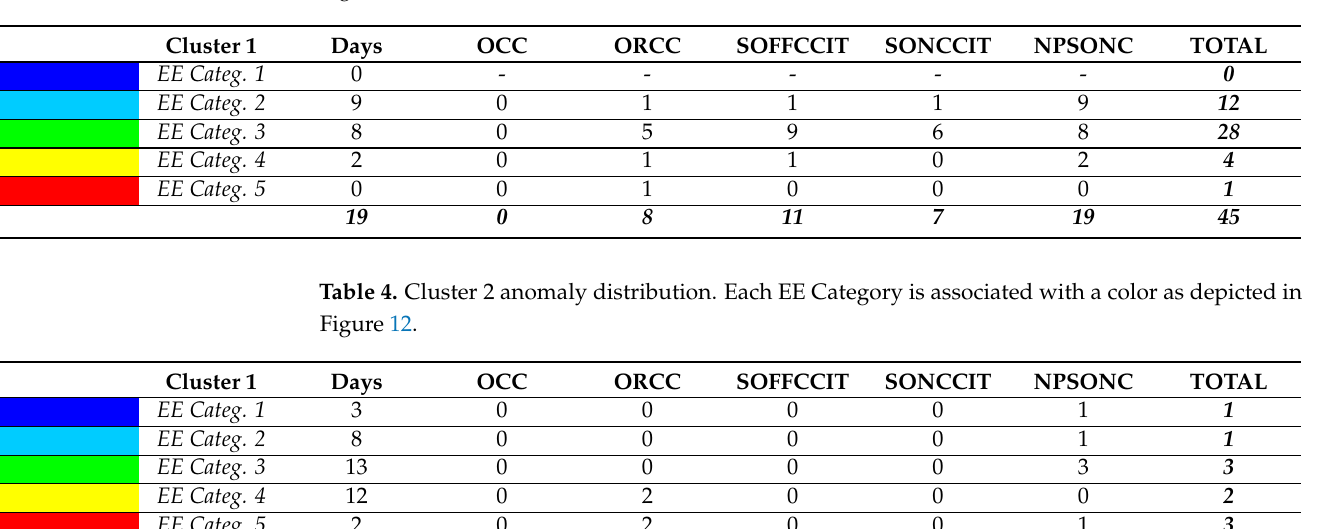
Table 3. Cluster 1 anomaly distribution. Each EE Category is associated with a color as depicted in Figure 12.